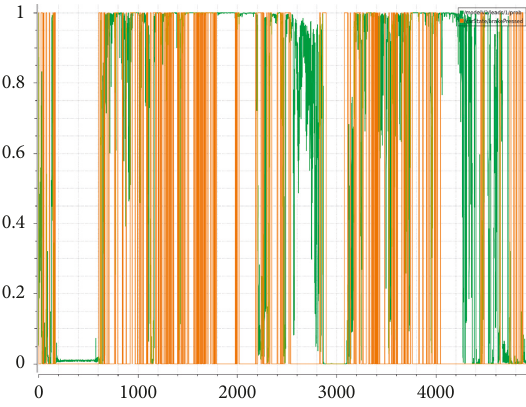
Figure 32: T1N1 lead car detection and